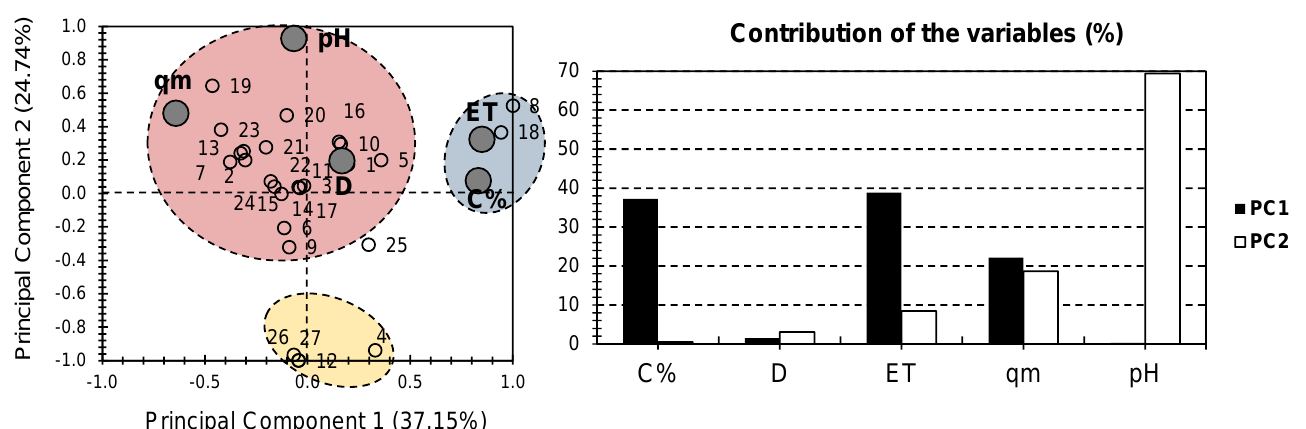
Figure 1. PCA for all datasets. Small empty bullets represent the 27 investigated hydrogels containing MONPs. Large gray bullets represent different physical and chemical properties.